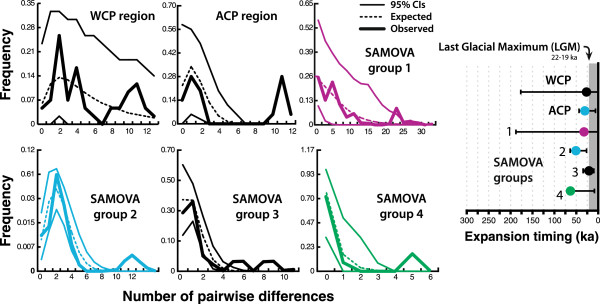
The six graphs at left show the frequency distributions of the numbers of pairwise cytb differences among H. formosa individuals for each SAMOVA-inferred population group and regional group, with confidence intervals on expected values derived from parametric bootstrapping (104 iterations) in Arlequin. Mean estimated timing of population expansions (circles) and 95% confidence intervals from parametric bootstrapping (bars) are plotted at right, with grey shading indicating time since onset of the LGM.